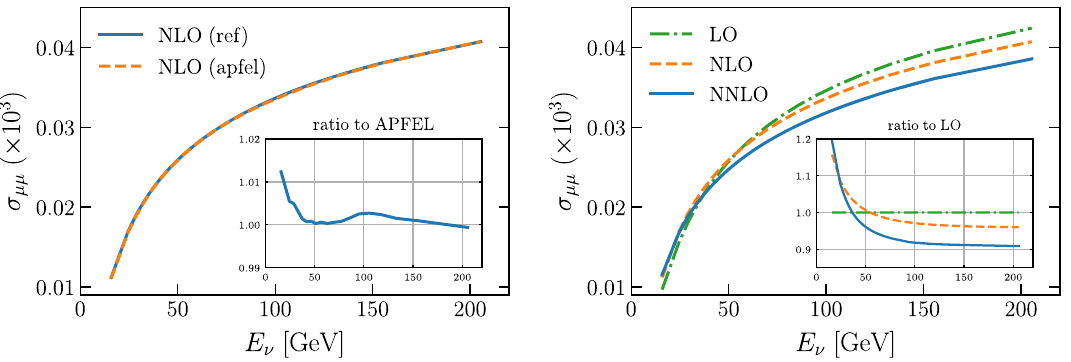
Fig. 1 Left: the integrated dimuon cross section as a function of the neutrino beam energy E ν , Eq. (2.1) (with i = μμ ), computed at NLO in the kinematic range measured by the NOMAD experiment with APFEL (apfel) and with a code based on [33] (ref). The ratio of the